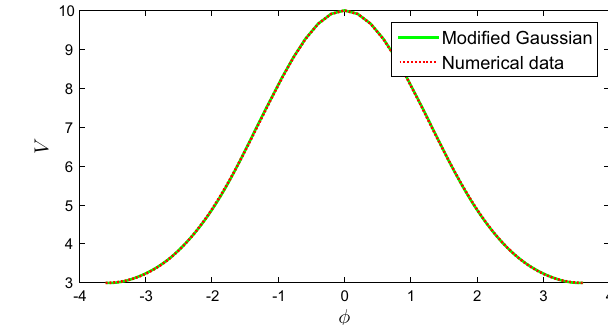
Fig. 8 Plot of V (φ) obtained from the numerical solution and by the fit defined by Eq. (37), for the values c = 0 . 5 and s = 1